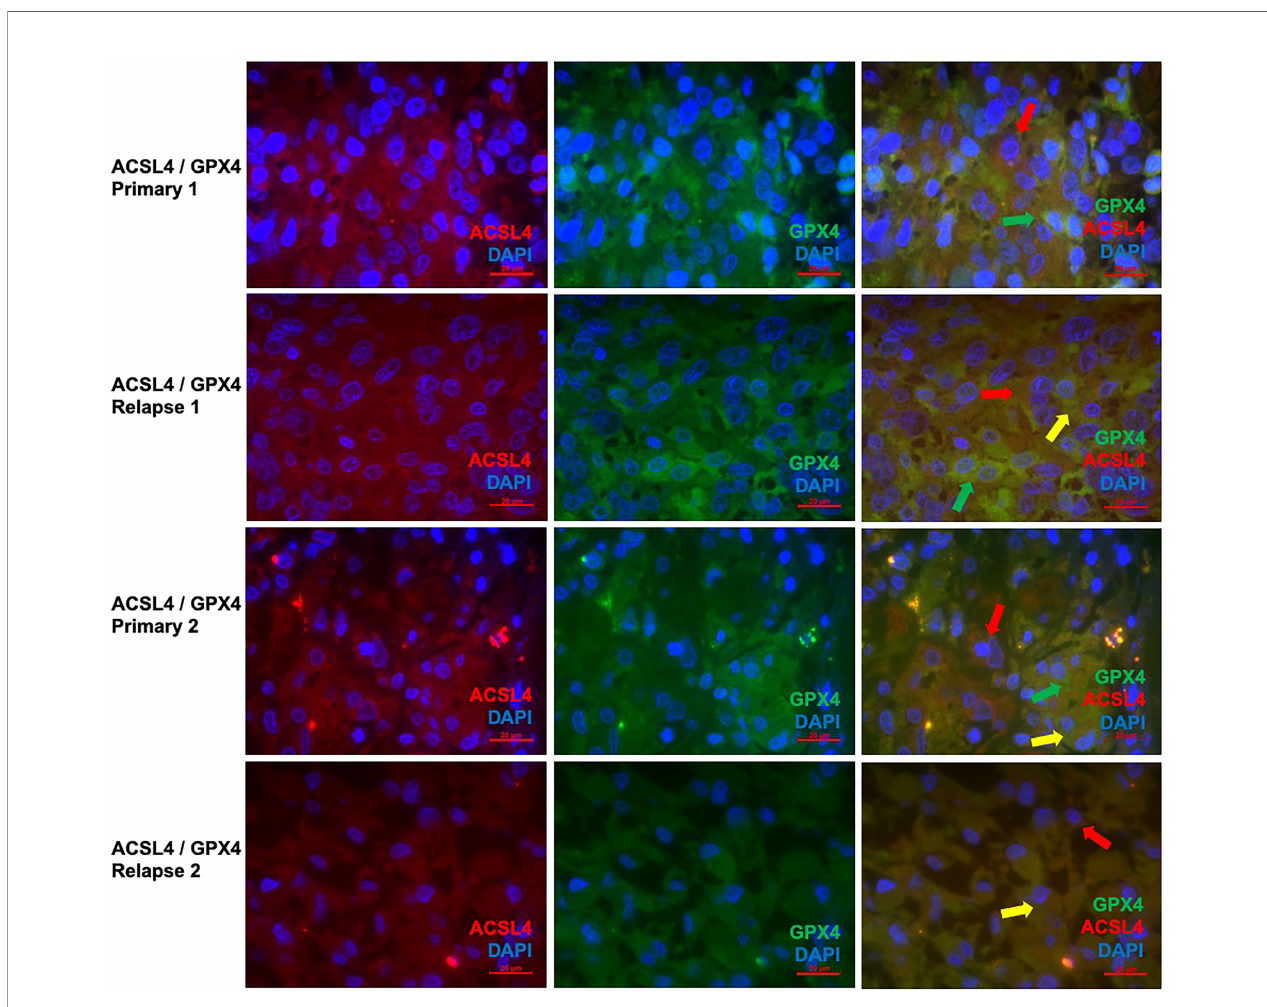
FIGURE 6 | Co-staining of both ferroptosis-related proteins in pairs of primary and recurrent GBM. (A – C) Double immuno fl uorescence with ACSL4 and GPX4 in a primary GBM (patient A) shows cells expressing either ACSL4 (red arrow) or GPX4 (green arrow). (D – F) Double immuno fl uorescence with ACSL4 and GPX4 in a relapse GBM (patient A) shows several cells with co-expression (yellow arrow), as well as only ACSL4 + cells (red arrow) and GPX4 + cells (green arrow). (G – I) Double immuno fl uorescence with ACSL4 and GPX4 in a primary GBM (patient B) shows ACSL4 + cells (red arrows) and GPX4 + cells (green arrow). Some cells express both ACSL4 and GPX4 (yellow arrow). (J – L) Double immuno fl uorescence with ACSL4 and GPX4 in a relapse GBM (patient B). Whilst many cells show co-expression (yellow arrow), one cell only expressing ACSL4 is marked (red arrow). Scale bars all 20 m